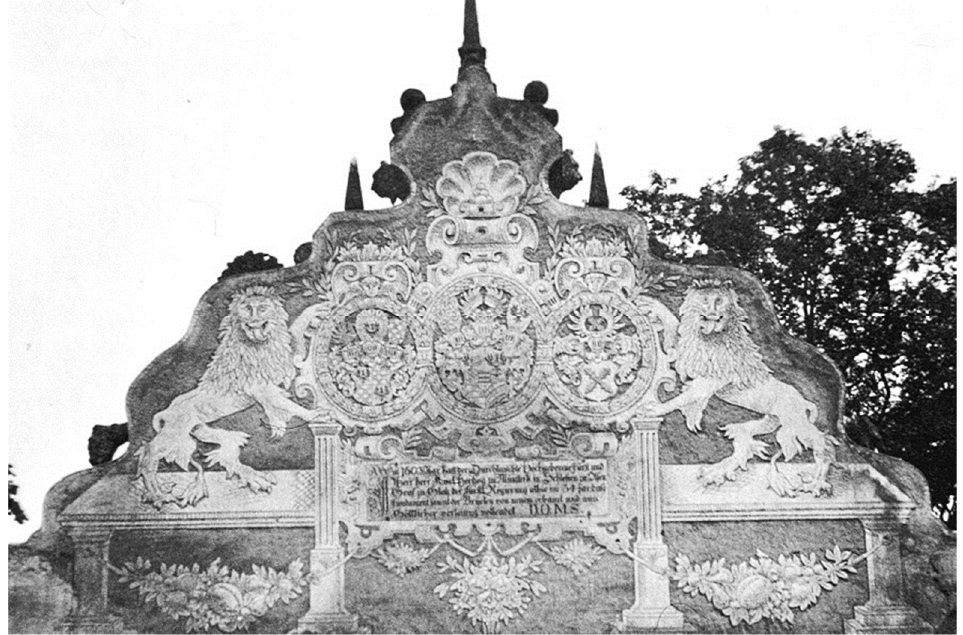
Figure 9. Sgraffito decoration of the top of the gate leading to the castle in Oleśnica. Source: Lutsch (1903, fol. IV).